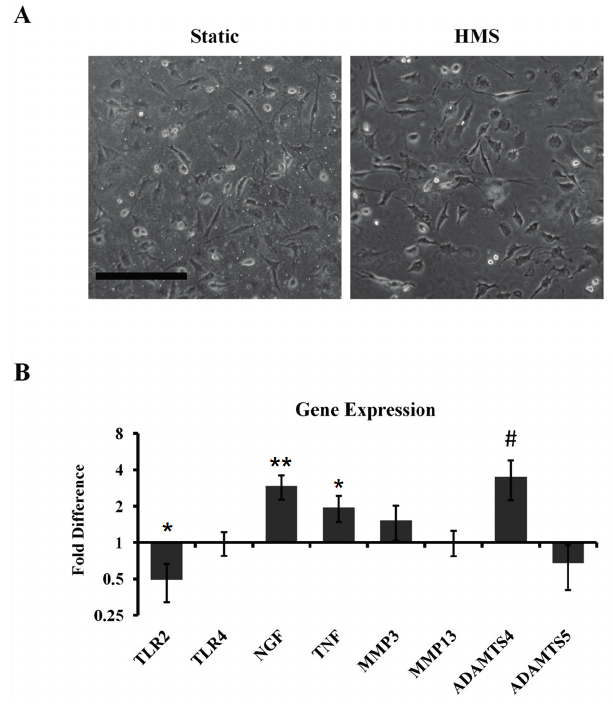
Figure 2. Application of the 8–16–8 stretch protocol to primary articular chondrocytes. ( A ) Representative morphological images of static and HMS cultured primary articular chondrocytes. Scale bar: 200 μ m; ( B ) Gene expression analysis immediately after stretch protocol ended. Error bars: ±SEM, n = 6 ( TLR2 , TLR4 , NGF and TNF ); n = 3 ( MMP3 , MMP13 , ADAMTS4 and ADAMTS5 ). Student’s t -test. * indicates p < 0.05; ** indicates p < 0.01; # indicates p =